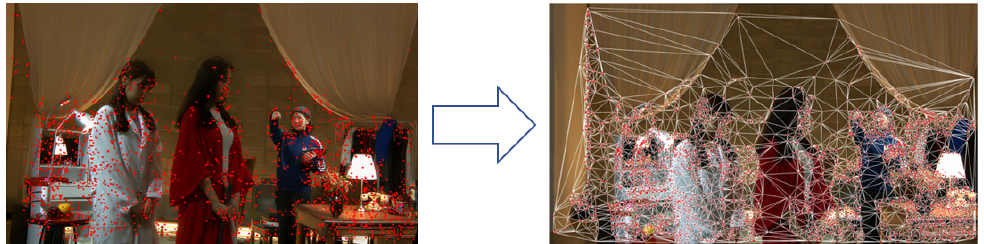
Figure 9. A Delaunay triangle is generated followed by feature extraction. Triangulation (right image) is generated based on feature extraction (left